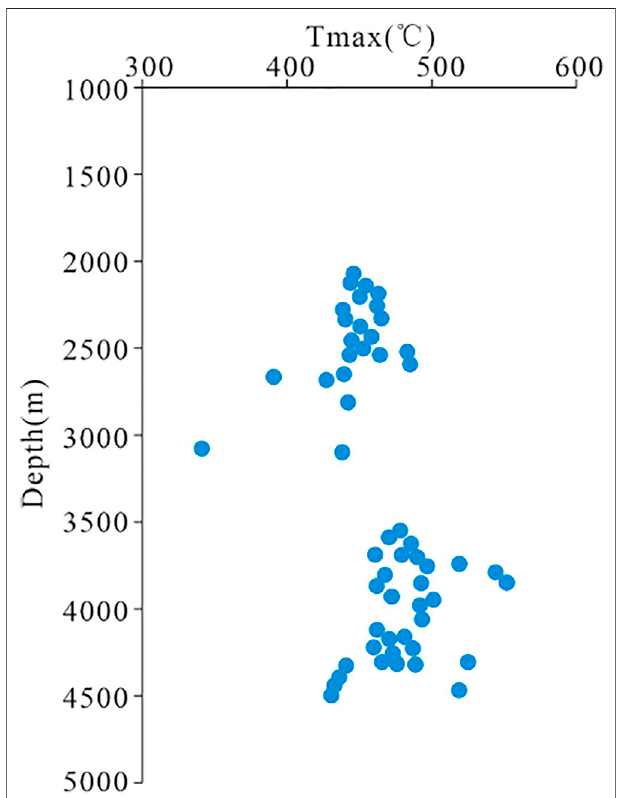
FIGURE 7 | Relationships between Tmax and the depth of the Upper Paleozoic reservoirs in the Dongpu Depression (Yang, 2018).